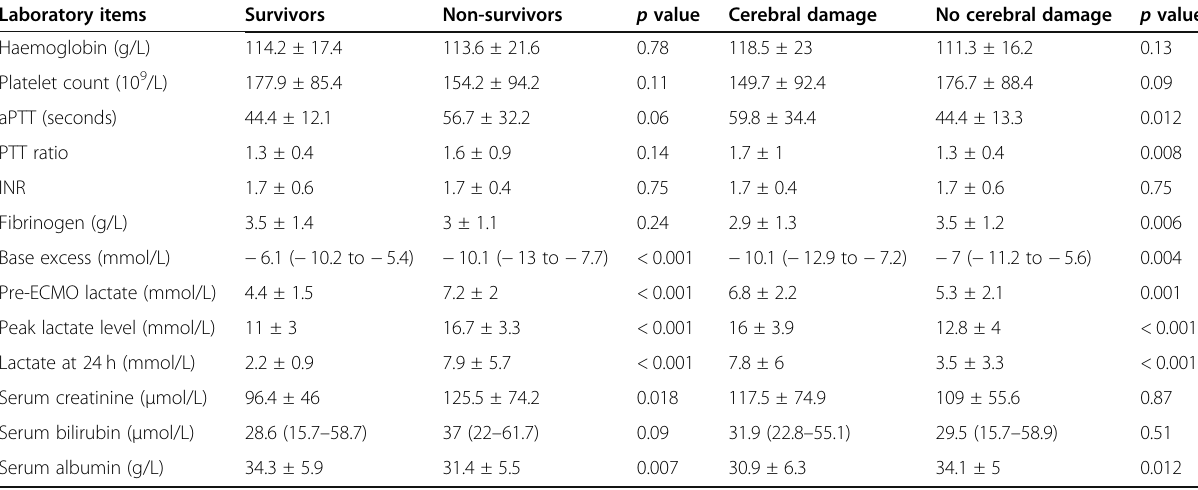
Table 2 Laboratory workup at ECMO insertion Laboratory